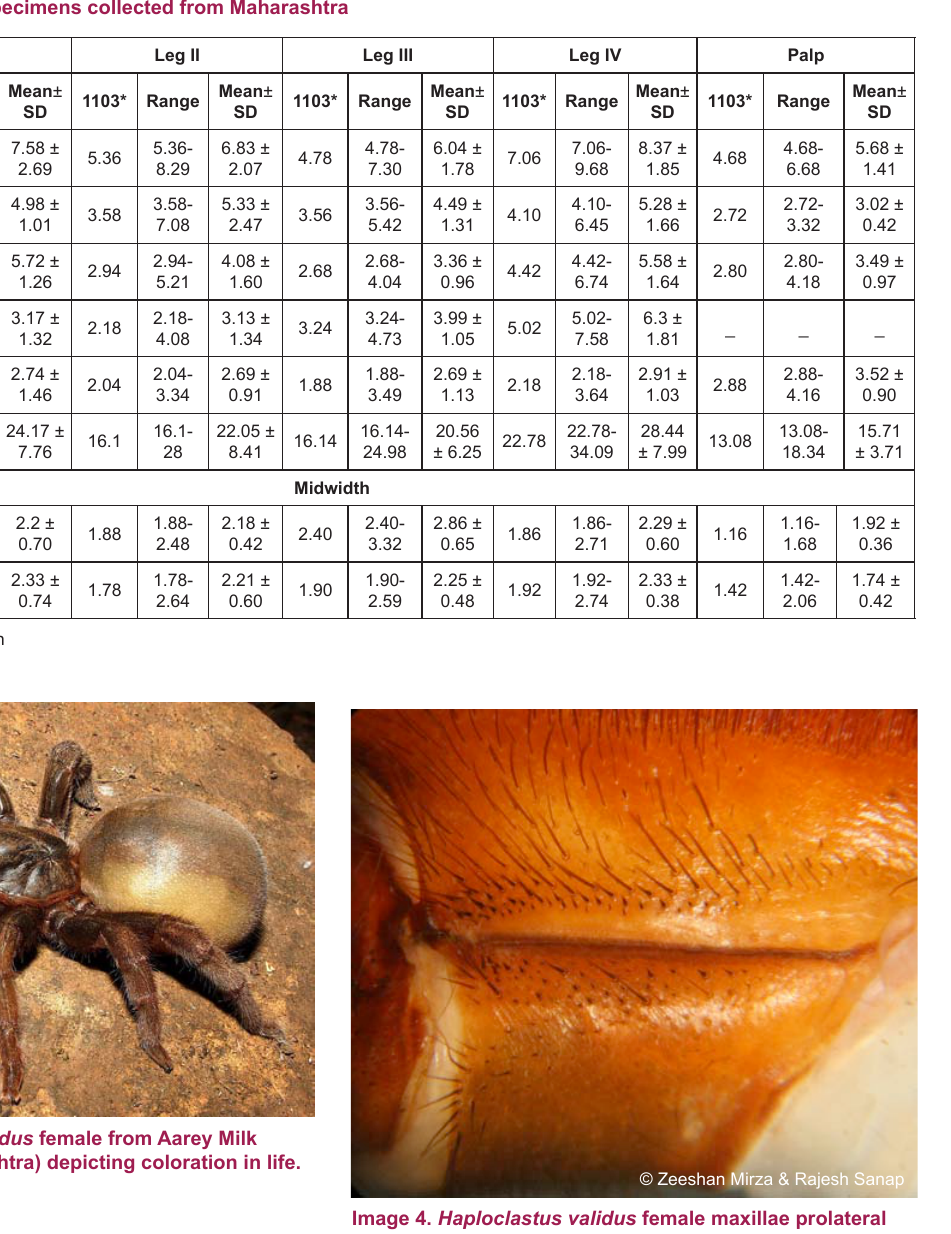
long; front width 0.90 and back width 1.18. Clypeus absent. Maxillae: Prolateral face with three to four rows of thorn setae intermixed with long spine-like bristles above and below the maxillary suture. Long spine setae scattered above as well as below the thorn rows.